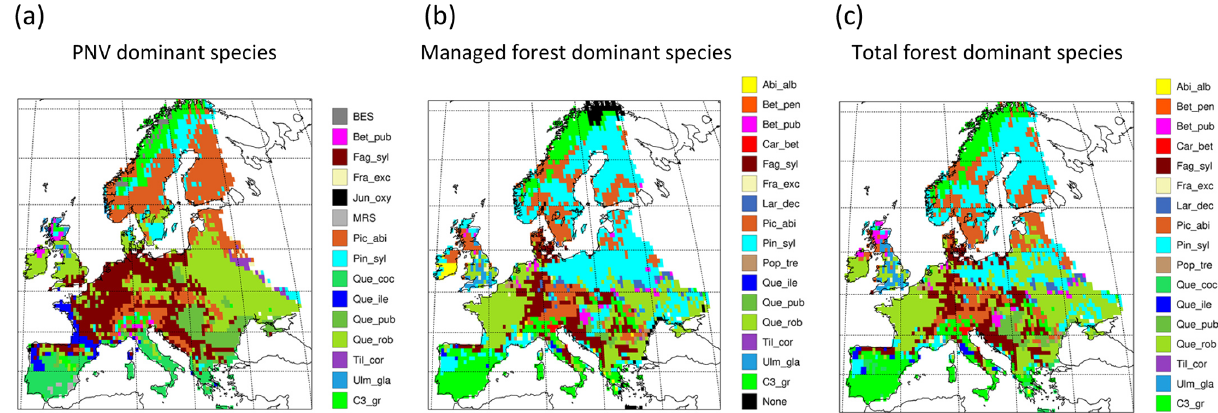
Figure C4. Modelled LPJ-GUESS dominant species (LAI) (including grass) in (a) primary forest (modelled as PNV), (b) secondary forest (managed with automated thinning), and (c) the total forest landscape in 1986–2015. Abbreviations of LPJ-GUESS tree species are as in Fig. C2: BES (boreal evergreen shrub), MRS (Mediterranean raingreen shrub), and C3_gr (C3